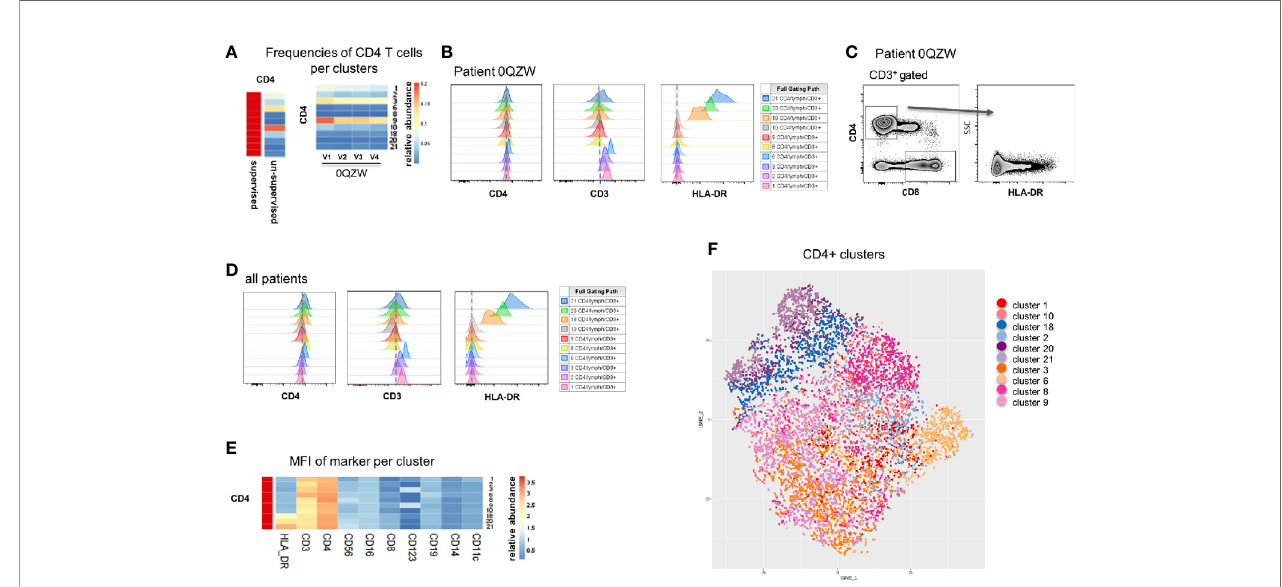
FIGURE 3 | Analysis of CD4 + T cell subsets identi fi ed by MegaClust. (A) Comparison of the different CD4 + cell clusters identi fi ed by MegaClust. Left panel shows one population of CD4 + T cells obtained by supervised analysis, whereas the unsupervised analysis identi fi ed 10 clusters within the CD4 T cell population. Four timepoints (visits, V1-V4) are shown for representative patient 0QZW. (B) Expression of CD4, CD3 and HLA-DR on the 10 CD4 T cell clusters on V1 from one representative patient 0QZW. (C) Expression of HLA-DR on CD4 T cells from patient 0QZW from the supervised dataset. (D) Cumulative analysis on all patients and timepoints (n=20) of the expression of CD4, CD3 and HLA-DR on the 10 CD4 + cell clusters. (E) Cumulative analysis on all patients and timepoints (n=20) of the expression level (mean fl uorescence intensity, MFI) of different markers on all CD4 T cell clusters. (F) tSNE of all CD4 + T cell clusters identi fi ed with